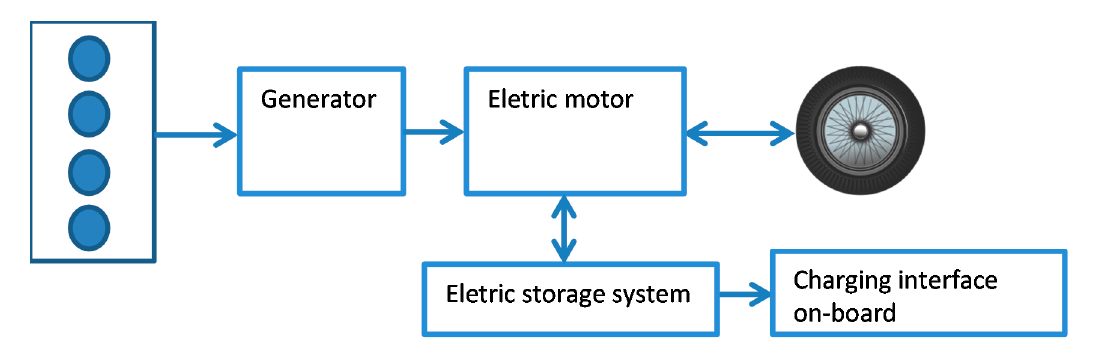
Figure 4. PHEV flex fuel Figure 4. PH EV flex fuel powertrain. Table 6. Technical specifications of plug-in 7900 Electric Hybrid bus from Volvo (PHEV).